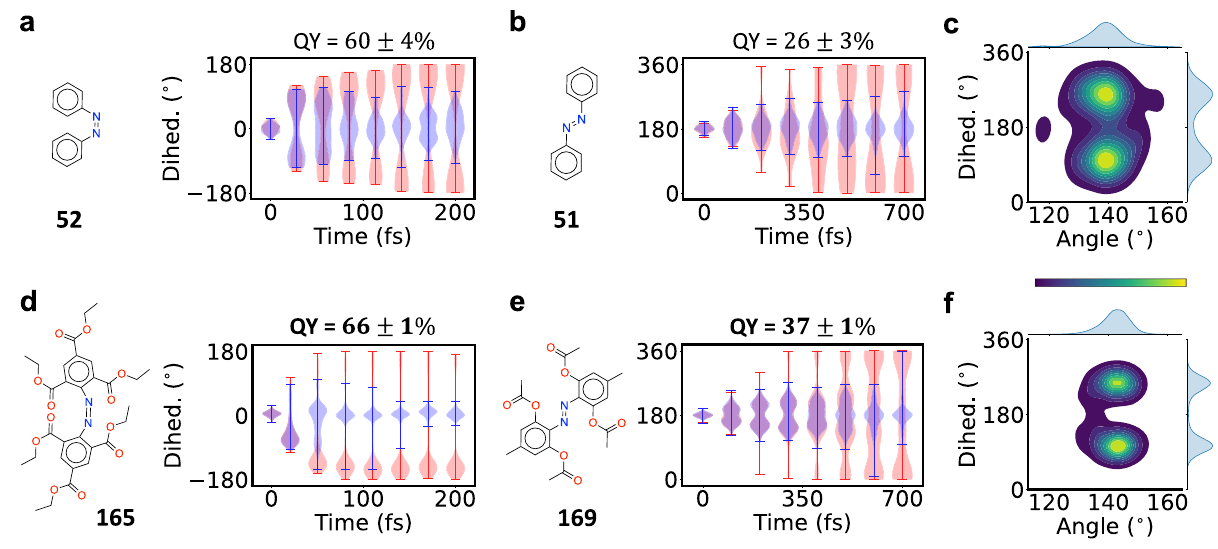
Fig. 5 Visualization of high-accuracy non-adiabatic dynamics for several compounds of interest. a - b , d – e Violin plots showing the CNNC dihedral angle vs. time. Reactive and non-reactive NAMD trajectories are shown in red and blue, respectively. The violin width at a given dihedral angle indicates the density of trajectories with that angle. The yield of each compound is shown above the plots. For ease of visualization we have used the range [ − 180, 180] for cis dihedral angles and [0, 360] for trans dihedral angles. c Distribution of hopping geometries for trans azobenzene. f As in ( c ), but for the derivative 169 . The density is visualized with kernel density estimation as a function of the CNNC dihedral and max ð α CNN ; α NNC Þ , where α is an angle. Yellow corresponds to the highest density and blue to the lowest. The marginal distributions over single coordinates are shown above and to the right of each